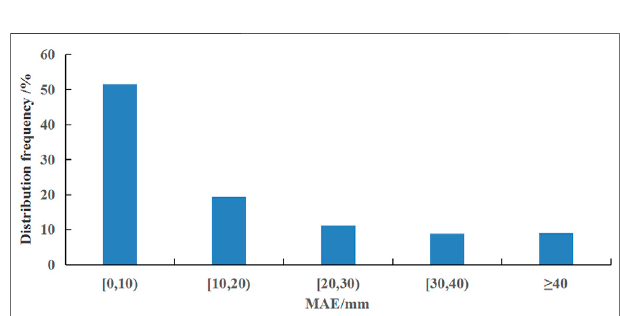
FIGURE8| Frequency distribution oftheMAE forthe cross-validationof